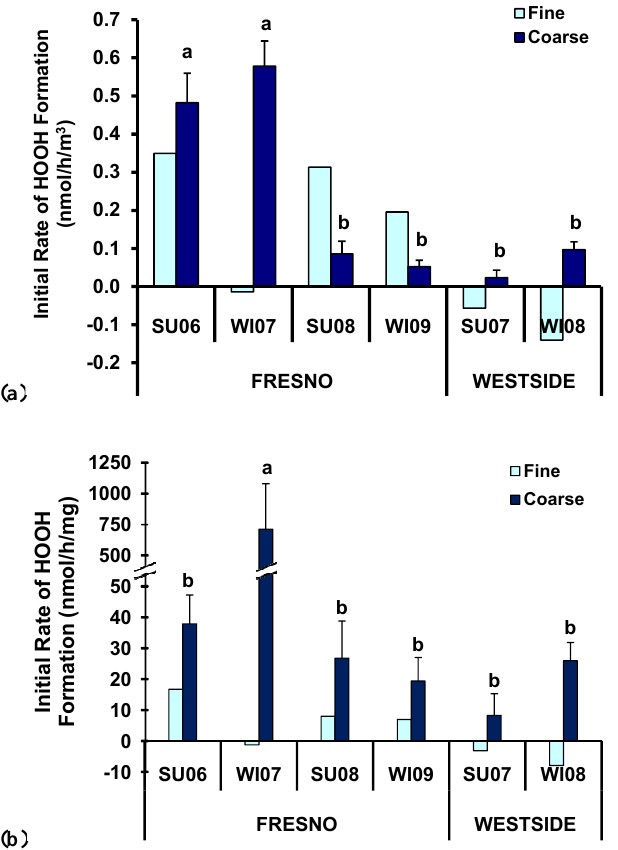
Fig. 3. Rates of HOOH generation in the absence of ascorbate. (a) shows air-volume-normalized initial rates of HOOH formation, while (b) shows PM-mass-normalized initial rates. Fine PM, n = 1. Coarse PM, values are means ± SD, n = 3. Letters above bars indicate statistically different rates: a >b .